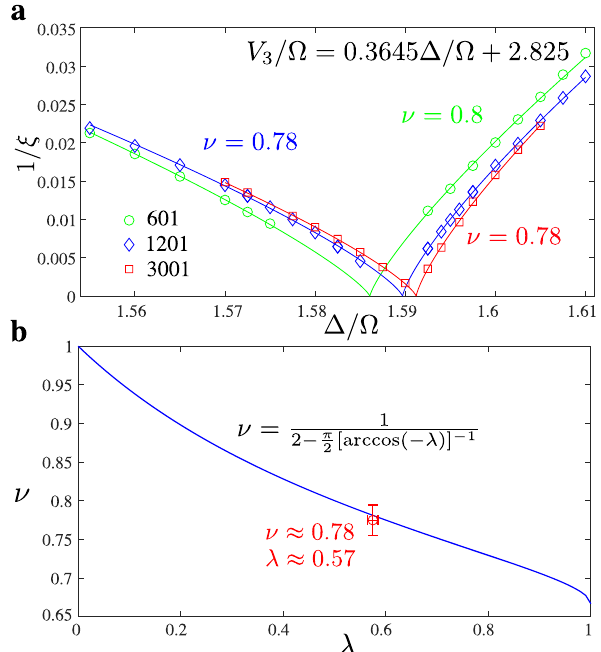
Fig. 9 Extraction of the correlation length exponent ν and comparison with Ashkin – Teller model. a Inverse of the correlation length along the commensurate line. b Critical exponent ν as a function of the Ashkin – Teller asymmetry parameter λ . The dark blue line shows the exact result of refs. 28,29 . The open red circle is the numerical result of this work ν ≃ 0.777 (result for N = 3001 shown in panel a , fi nite-size error do not exceed ±0.02) and λ ≃ 0.57 ± 0.01 as shown in Fig.